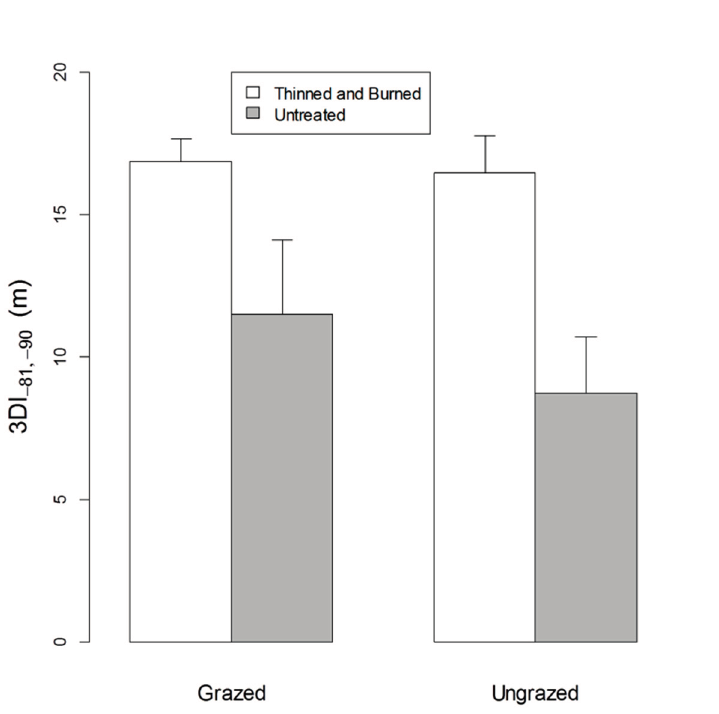
Figure 4. Mean values of the Three-dimensional Vegetation Density Index (3DI) for zenith angles between − 81° and − 90° for grazed and ungrazed plots that were either thinned and burned or untreated. Standard error bars are